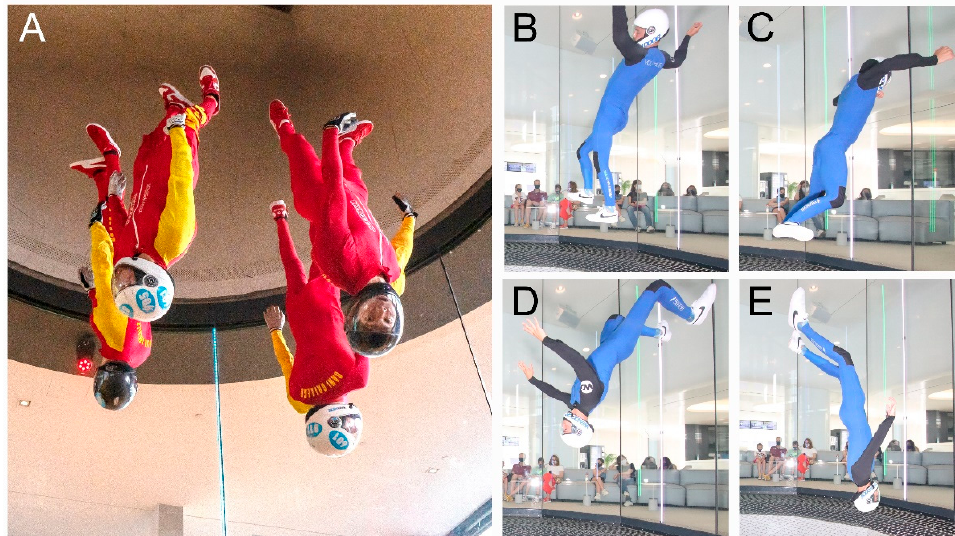
Figure 2. ( A ) Indoor Skydivers from Royal Spanish Aeronautical Federation. ( B ) Head-up in-face position. ( C ) Head-up out-face position. ( D ) Head-down in-face position. ( E ) Head-down out-face position.